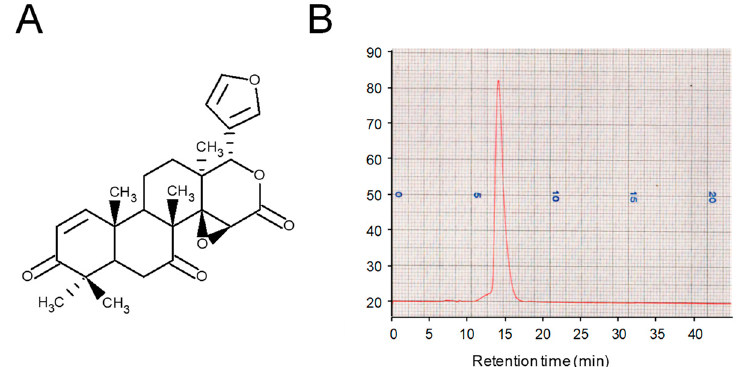
Figure 1. Purification of andiroba limonoid CG-1. ( A ) Chemical structure of the limonoid CG-1. ( B ) Chromatogram of CG-1 purified from the seeds of andiroba ( C. guianensis , Meliaceae) by HPLC.